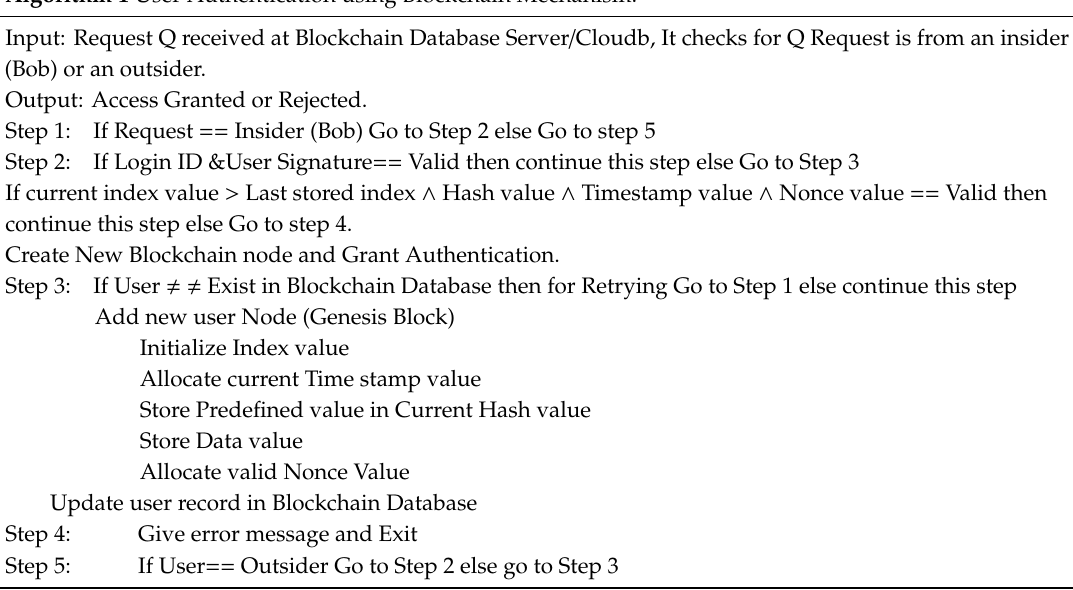
Algorithm 1 User Authentication using Blockchain